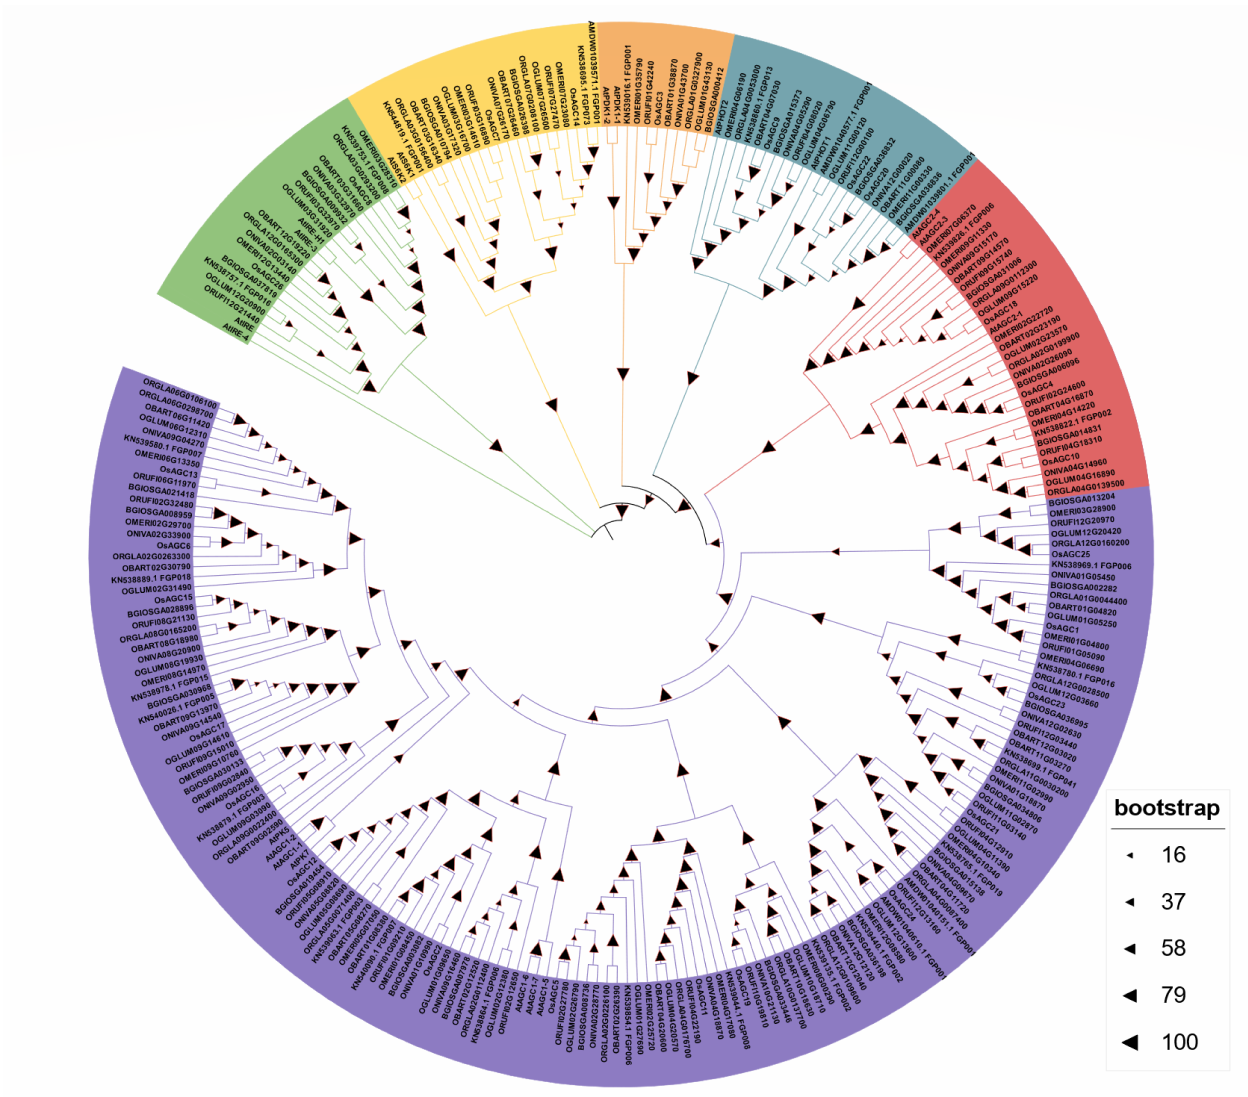
Figure 1. Phylogenetic relationship of AGC proteins identified in Oryza species and Arabidopsis